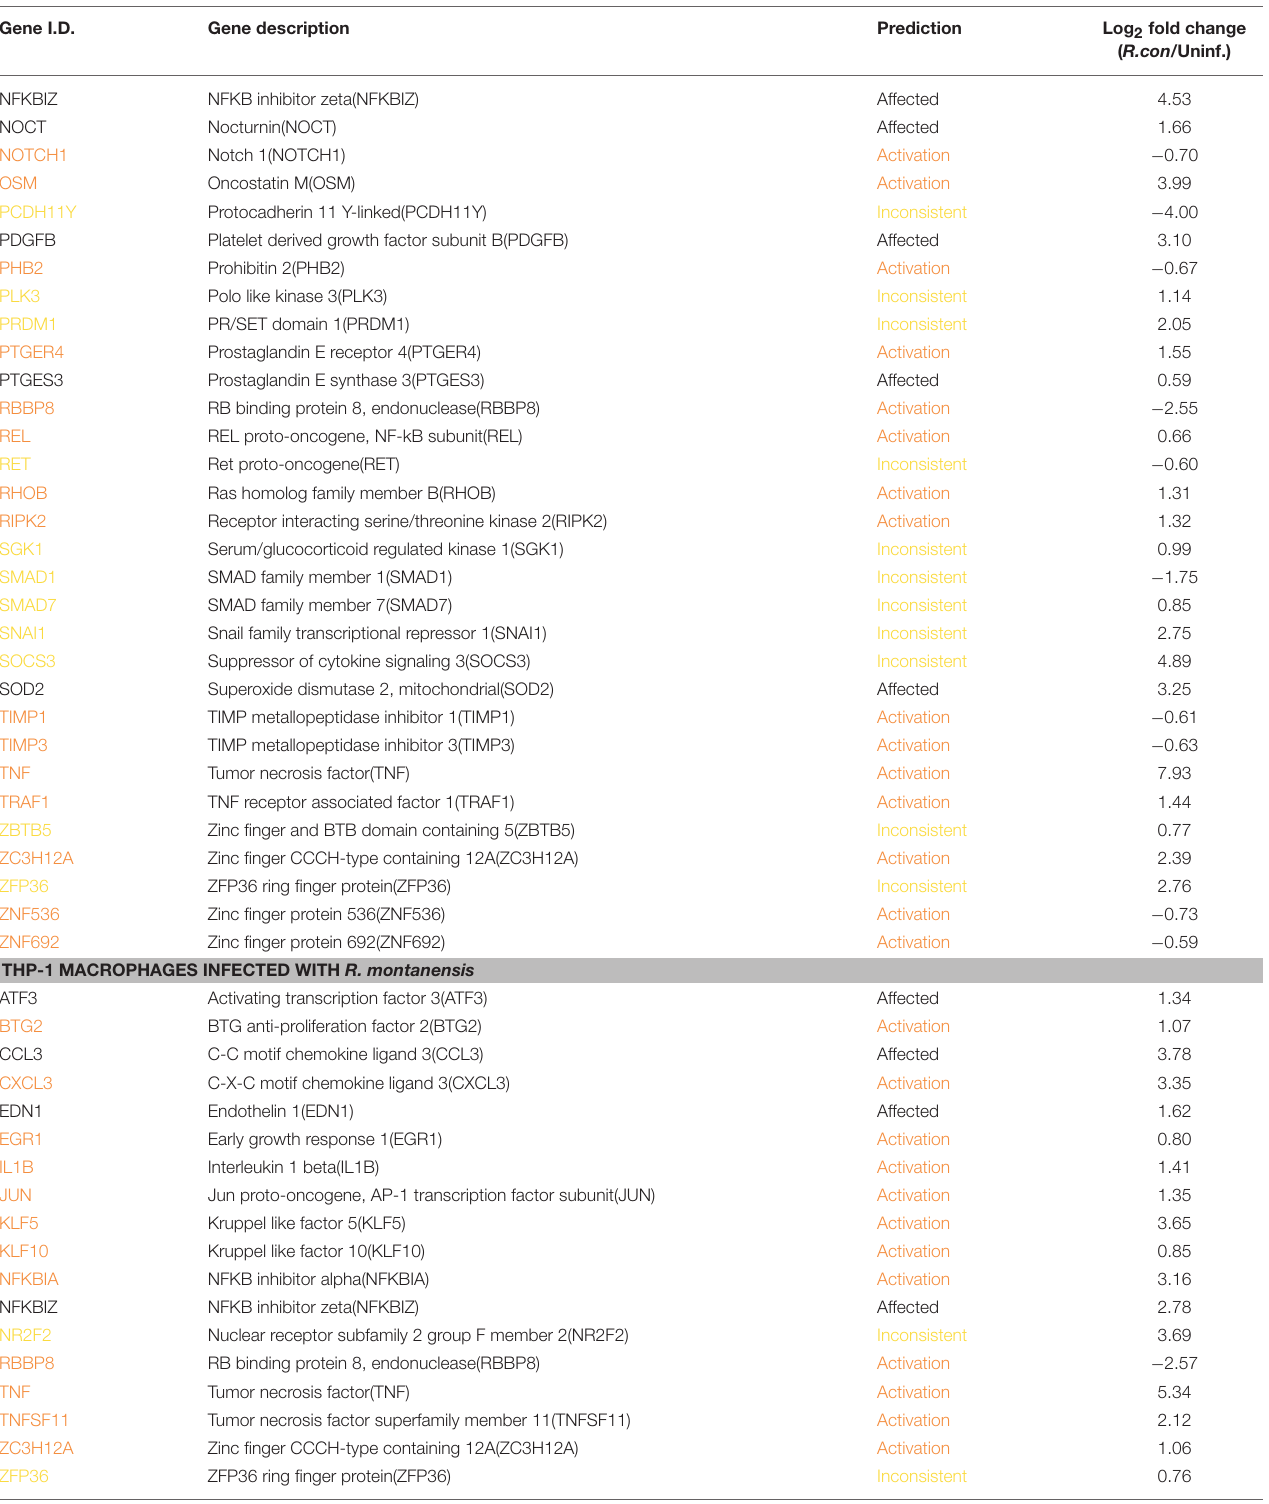
ZFP36 ZFP36 ring finger protein(ZFP36) Inconsistent 0.76 The software predicted activation/inhibition Z-scores of 2.428 (p-value of 5.27 x 10 − 14 ) and 2.647 (p-value of 7.48 x 10 − 6 ) for R. conorii- and R. montanensis-infected THP-1 macrophages, respectively. In IPA, Z-scores are used to predict activation or inhibition, where a Z-score ≥ 2.0 represents a statistical significant result of activation while a Z-score